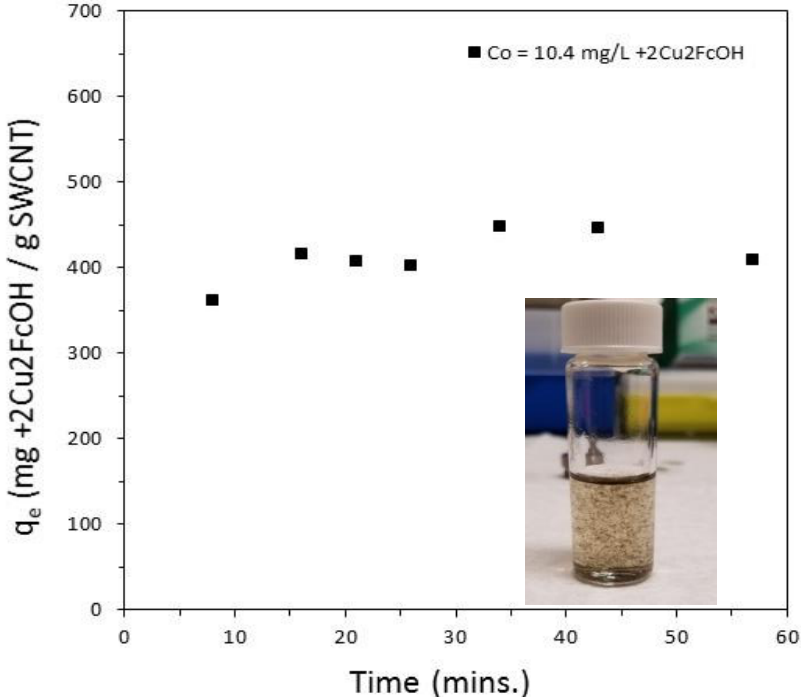
Figure 7. Kinetics of +2Cu2FcOH binding at an initial concentration of 10.4 mg L −1 . Binding stayed consistent up to 120 min, the typical length of incubation for adsorption studies. Equilibrium was reached faster than for any other molecular spacer previously studied. The inset shows aggregated dispersion after only 6 min of